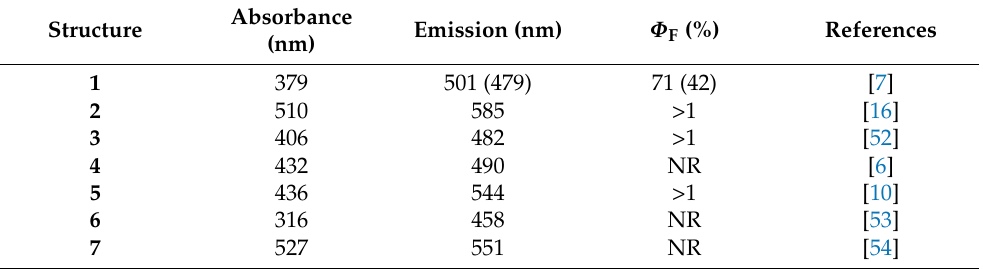
Table 4. Reported photophysical properties of 7-diethylamino-coumarins, used for comparison purposes.